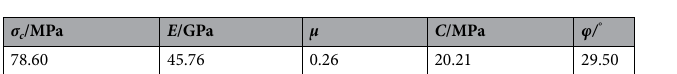
Table 1. Basic mechanical parameters of the tested graphite ore